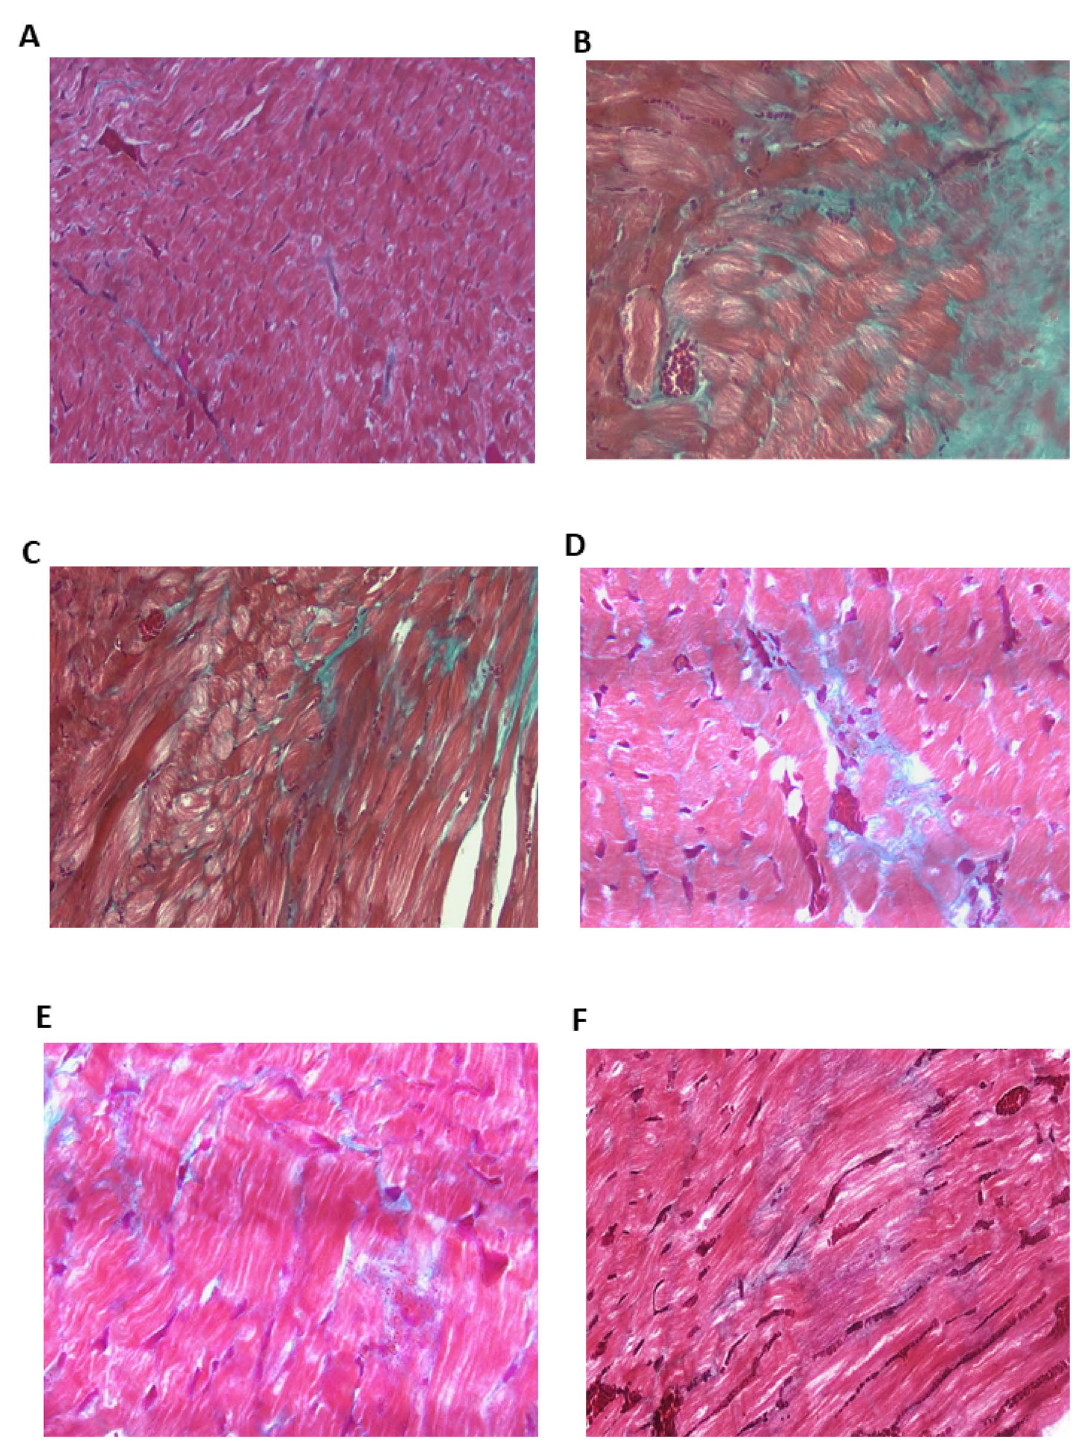
Figure 2. Photomicrograph of heart tissue sections in different studied groups using Masson’s trichrome staining. ( A ) Control group exhibited a minimal amount of collagen fiber deposition around blood vessels (×200); ( B ) model group (dexamethasone-treated group) showed prominent and dense collagen fibrosis in the left ventricle (×400); fibrosis occurred in both interstitial and perivascular regions in an unorganized manner; ( C ) PRV 0.5 mg/kg; ( D ) PRV 1 mg/kg; ( E ) PRV 2 mg/kg with less fibrosis (×400). ( F ) Losartan treatment reduces cardiac fibrosis and collagen fibers are deposited around blood vessels (arrows)